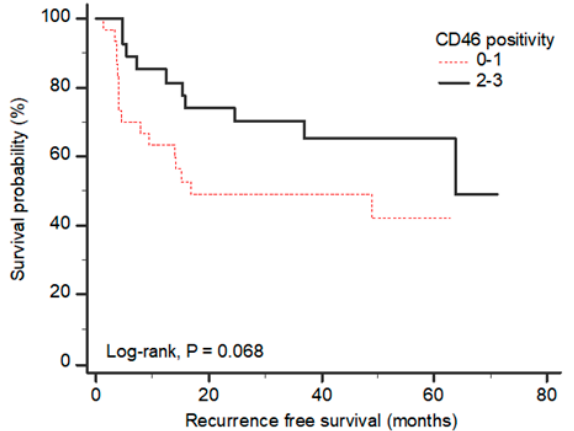
Figure 2. High CD46 expression indicates better survival of bladder cancer patients. Overall survivability was demonstrated by the Kaplan–Meier curve and measured by the log ‐ rank test ( p = 0.068).